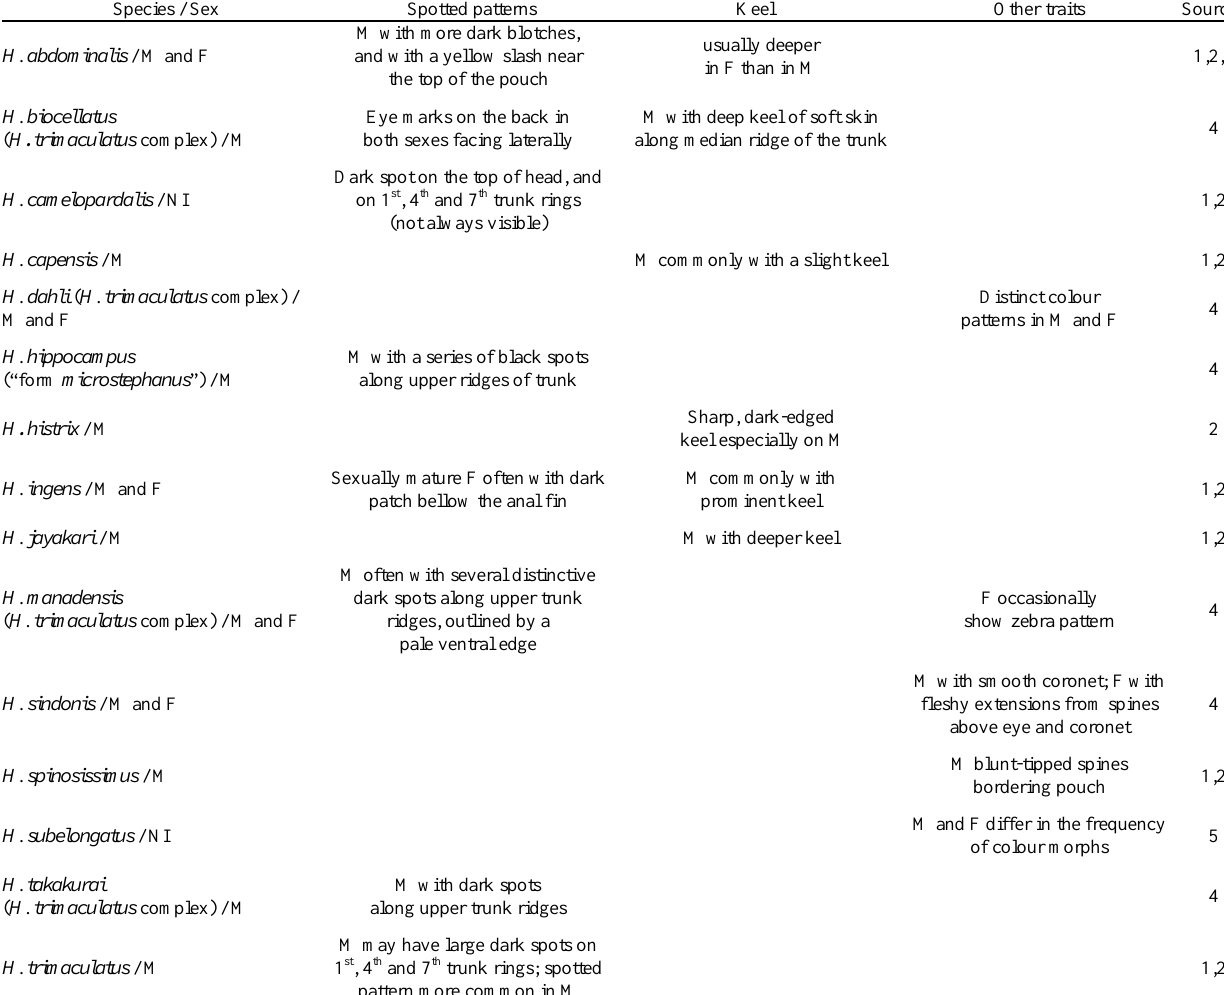
Table 1. Occurrence of distinct colour patterns and sexual dimorphism in genus Hippocampus . 1 = Lourie et al . (1999); 2 = Lourie et al . (2004); 3 = Vincent (1990); 4 = Kuiter (2009); 5 = Jones & Avise (2001). NI = Not informed; M = male; F =